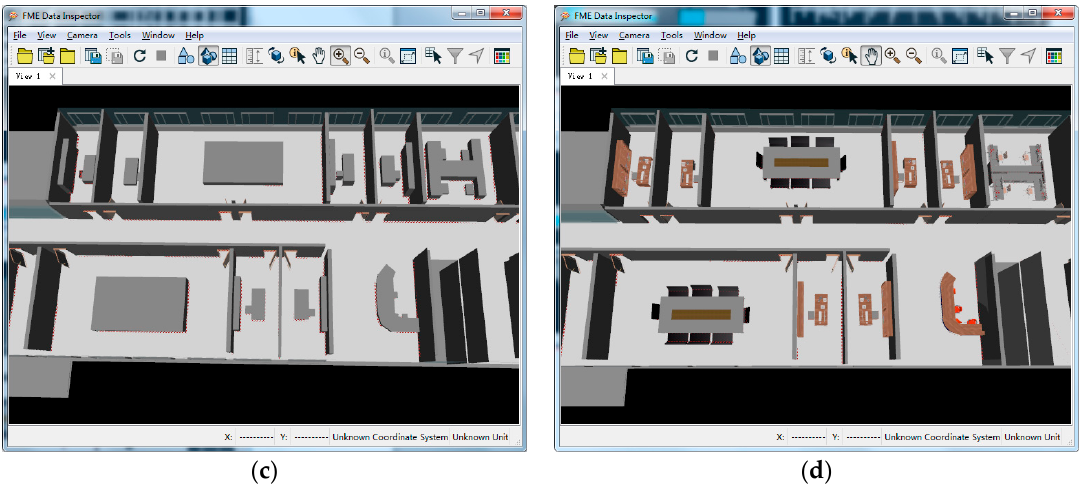
Figure 12. Experimental demonstrations. ( a ) The first and fifth story; ( b ) the frame structure; ( c ) representation for the interior furniture in ILoD 3; ( d ) representation for the interior furniture in ILoD 4.